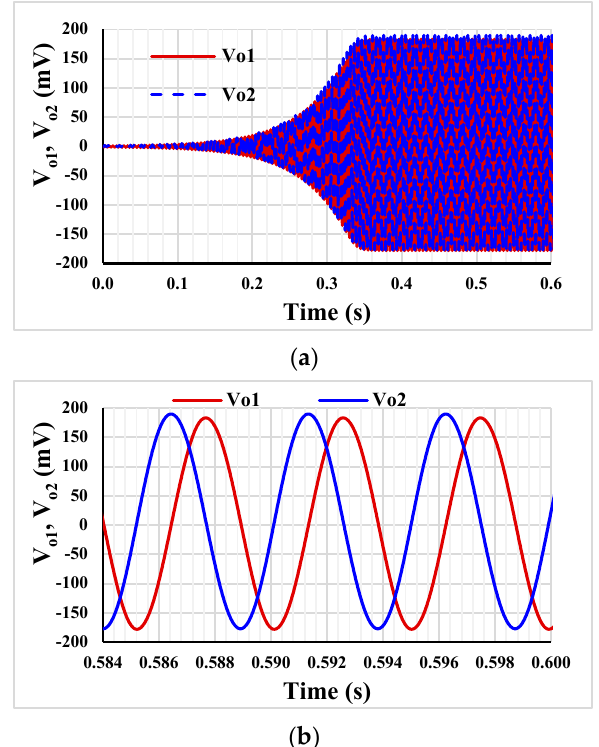
Figure 6. The running oscillation ( a ) and the steady state ( b ).